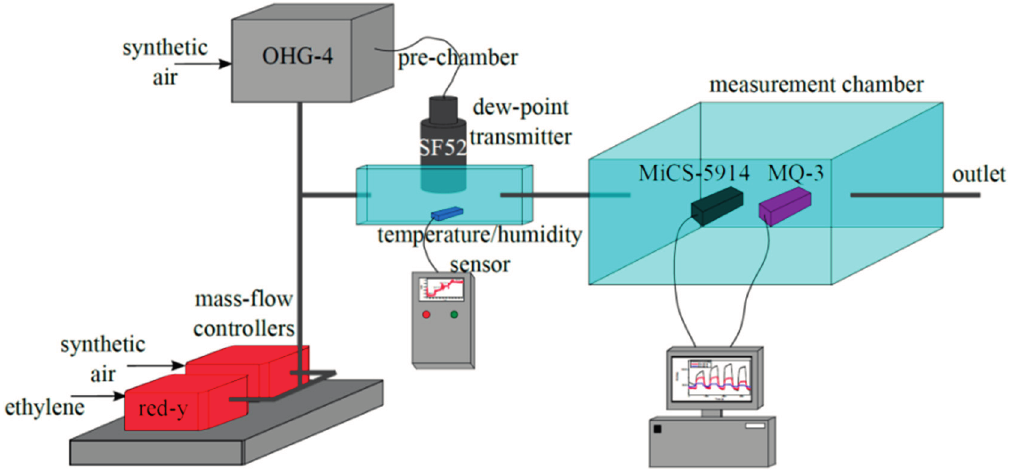
Figure 1. Schematic diagram of the gas measurement